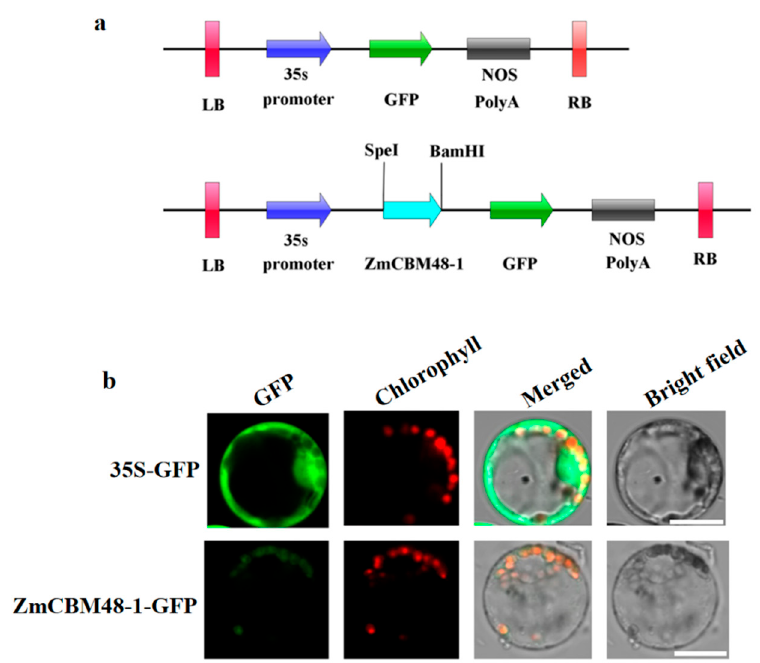
Figure 3. Subcellular localization of ZmCBM48-1. ( a ) Schematic representation of the ZmCBM48- 1-GFP fusion construct and the empty vector (GFP) used for the transient expression. ( b ) The fusion proteins and 35S::GFP DNA constructs were transiently expressed separately in themaize leaf protoplasts and were visualized under a confocal laser scanning microscope. Scale bar, 10 µm.